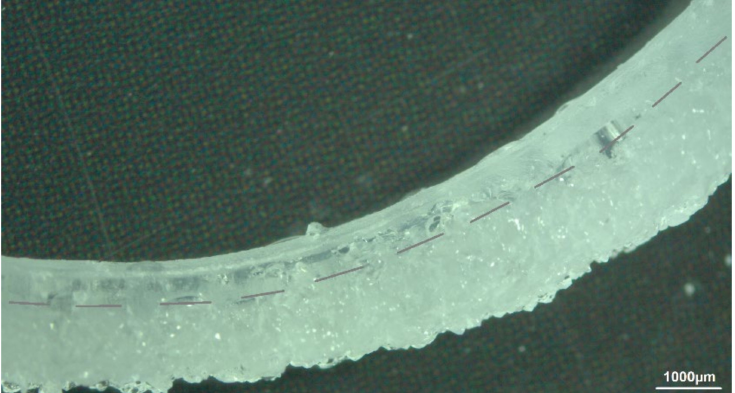
Figure 7. Optical microscopy image of swollen sample design B using Nusil Med 4850-PAMAA: swelling medium—Ringer solution; swelling time—168 h; hydrogel particle size fraction—77 µ m; initial hydrogel content—20 wt%.